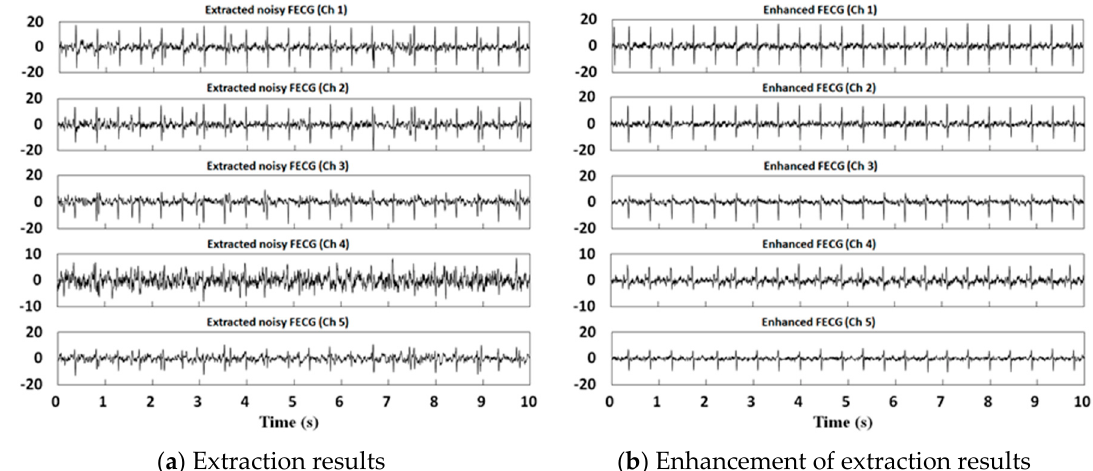
Figure 2. The extraction and enhancement of foetal electrocardiograms (FECGs) obtained using the proposed method for the DaISy database.